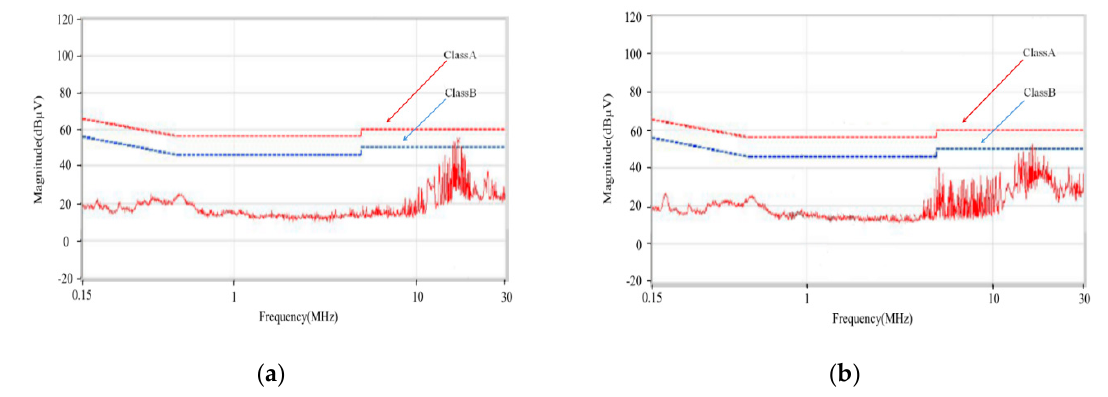
Figure 30. Experimental result of CM interference: ( a ) CM interference of single module on AC side; ( b ) CM interference of three module parallel DC side.